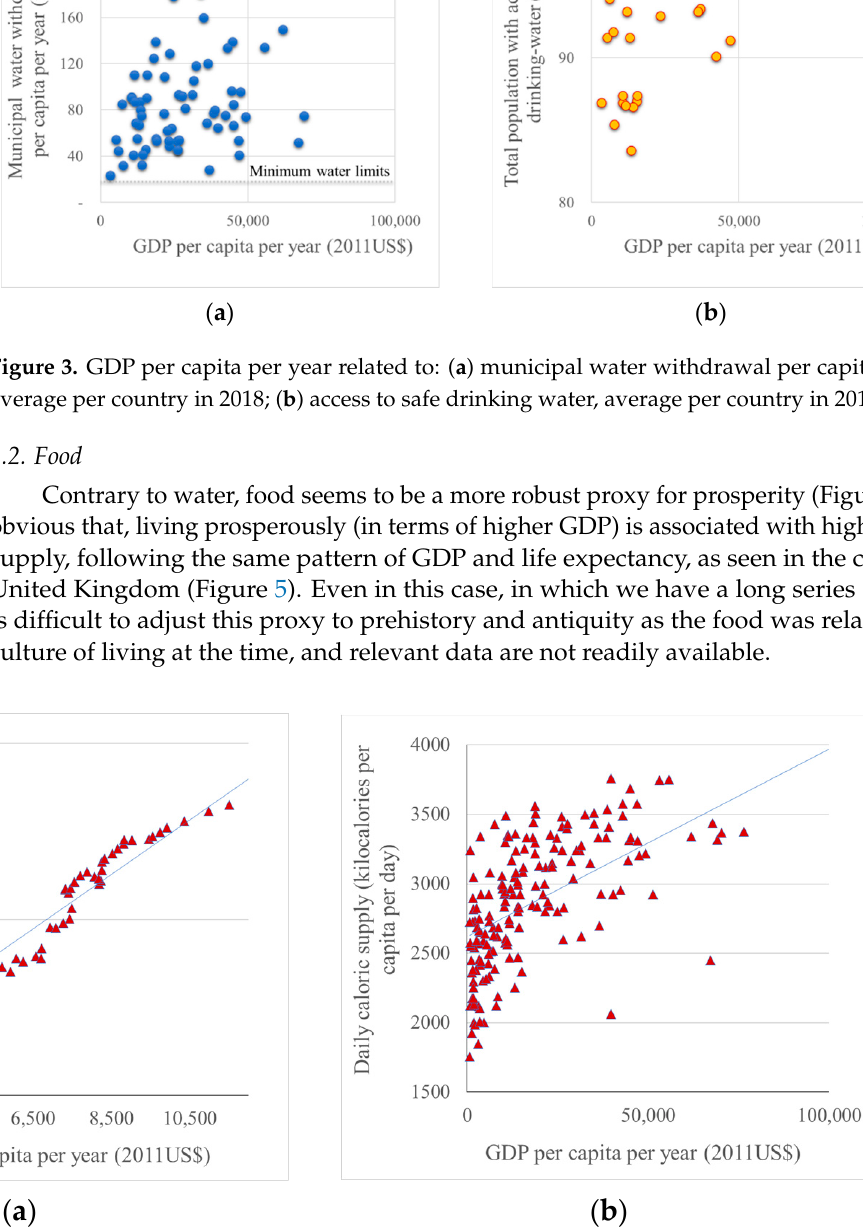
Figure 4. GDP per capita per year related to daily caloric supply; ( a ) global average through 1960– 2011; ( b ) average per country in 2018 [66].